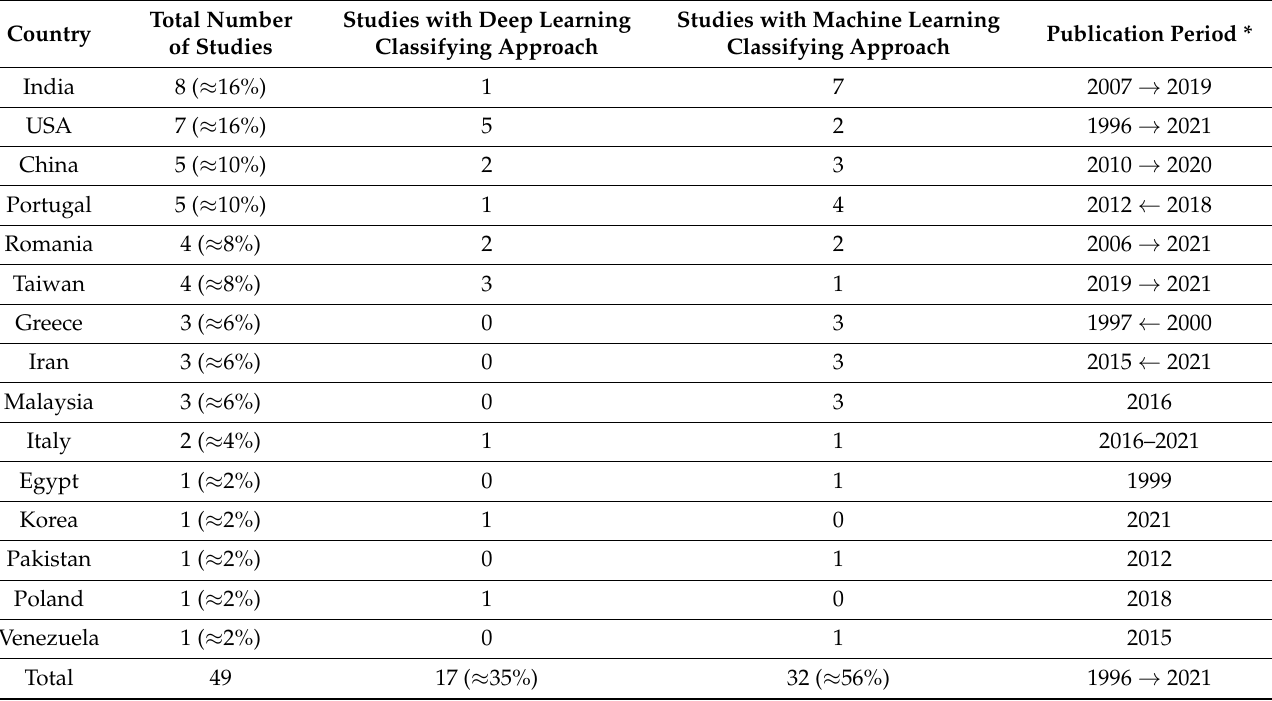
Table 2. Number of studies sorted by AI type.